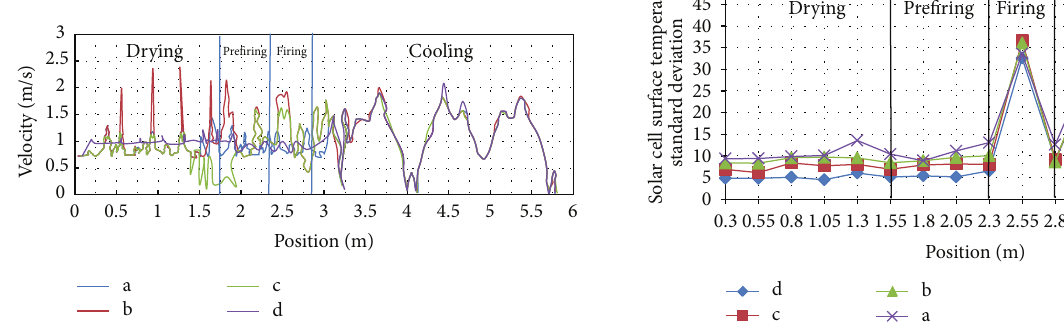
Figure 9: Airflow velocity vectors for the solar cell surface.